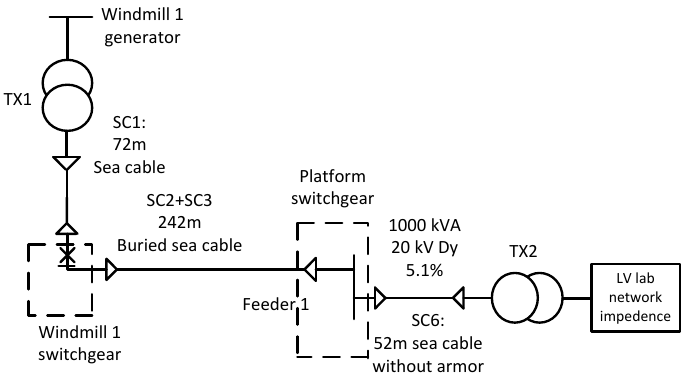
Figure 8. Single-line diagram representation of ASEA Brown Boveri (ABB) wind cable laboratory.